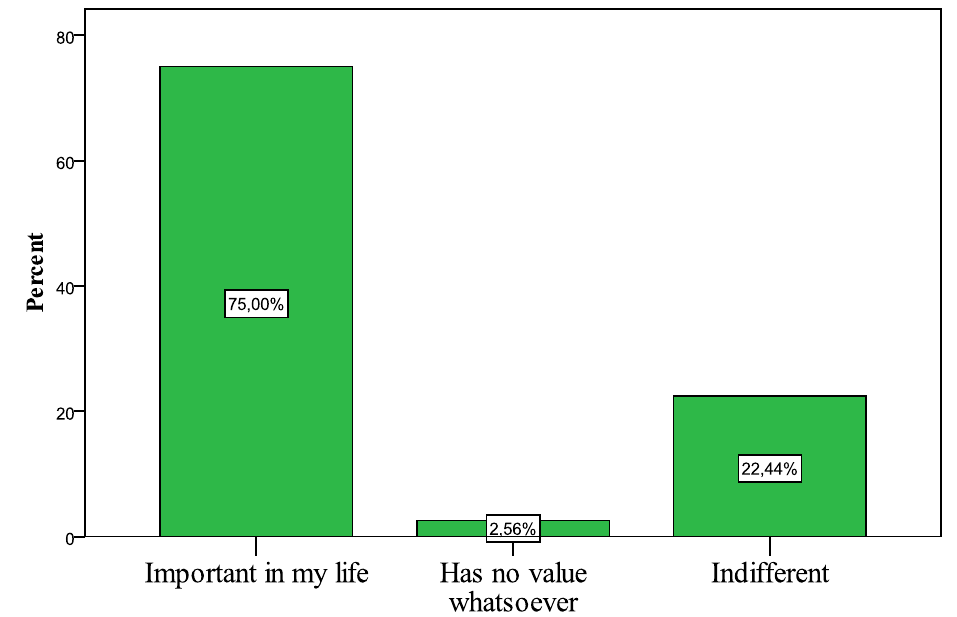
Fig. 1. The perceived importance of nature in life of high school students of Bielsko-Biała Table 2. Cross-analysis of the role of nature in the lives of high school students under the residence The role of nature (in %) District Has no value Important in my Indifferent Total whatsoever life